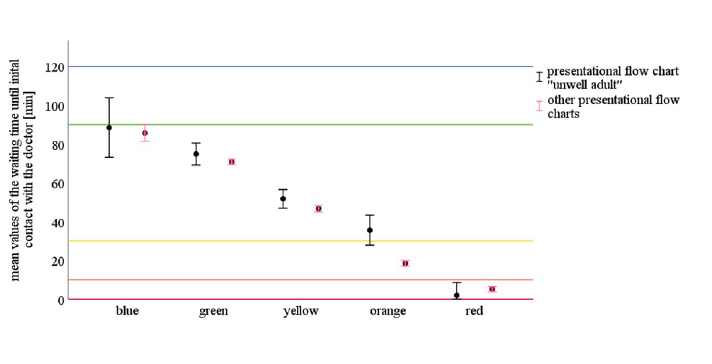
Fig 2. The mean values of the waiting time until initial contact with a doctor with 95% CI for the comparison groups of “unwell adult” and the other presentational flow charts. The colored lines refer to the predefined MTS time limits. Exceedances in the MTS category "red" (immediate contact with a doctor) may be caused by a delayed setting of the "doctor contact timestamp" in the computer system. This is conceivable if, e.g., all personal resources are primarily tied up in direct patient